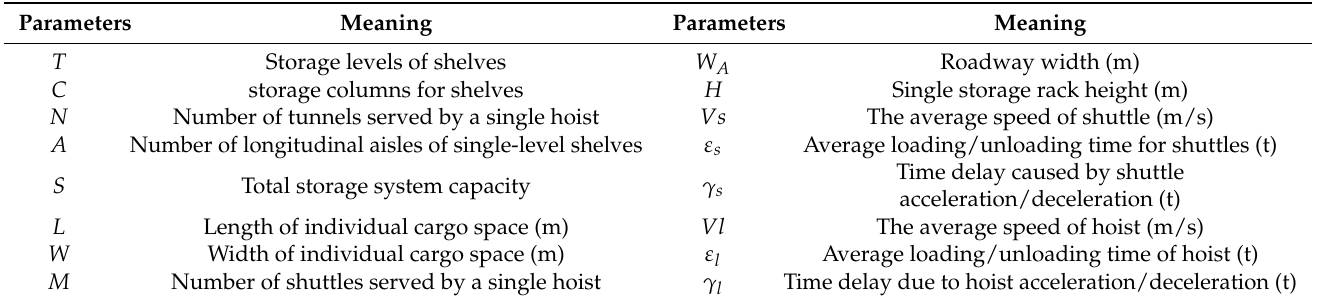
Table 2. Meaning of unknown parameters in the